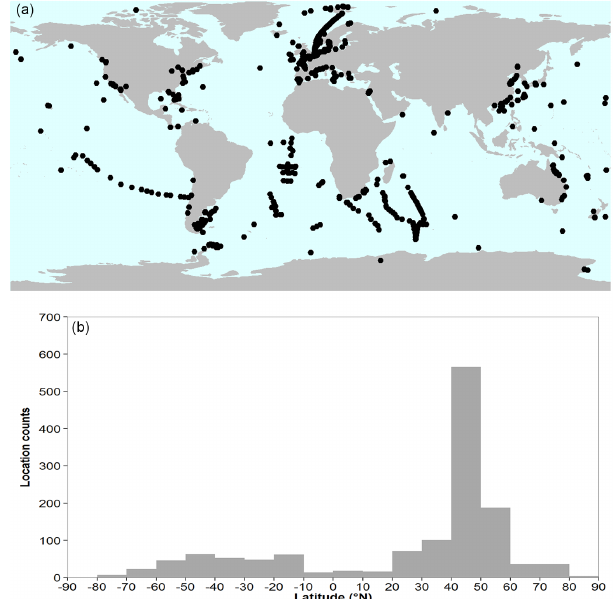
Figure 2. (a) Location of organisms and natural communities from which data has been archived and (b) distribution of locations ac- cording to